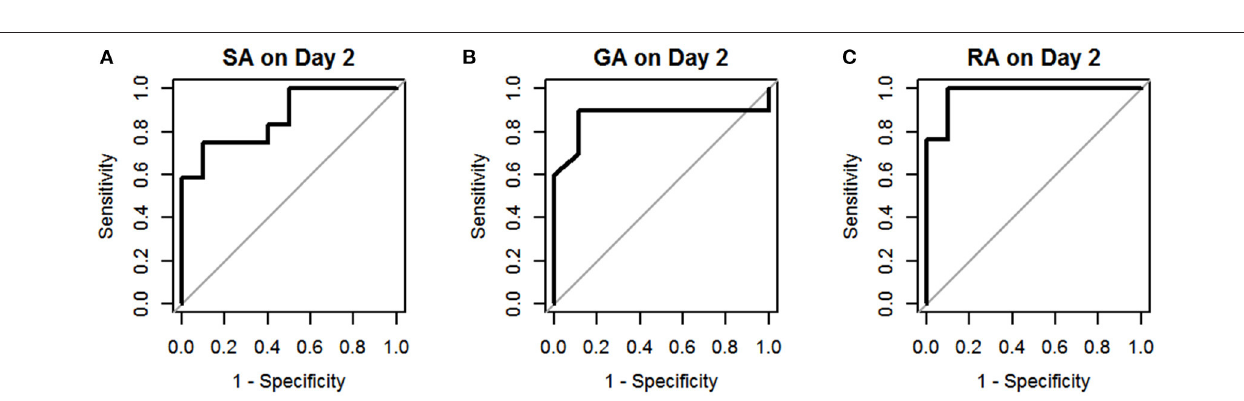
FIGURE 2 | Receiver operating characteristic curves for sCD40L in distinguishing children with acute appendicitis from NA on day 2: SA (A) , GA (B) , and RA (C) .